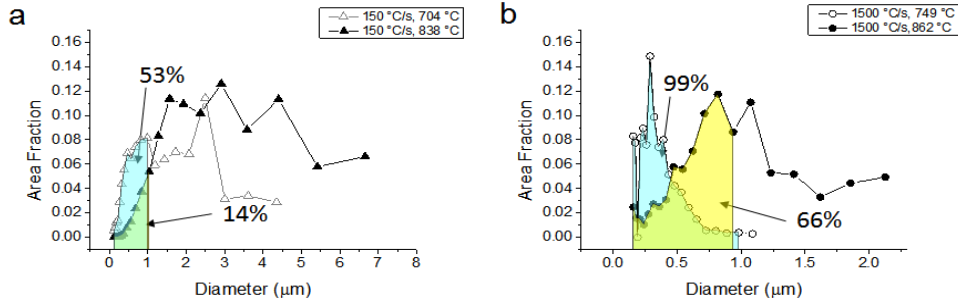
during heating at both heating rates.